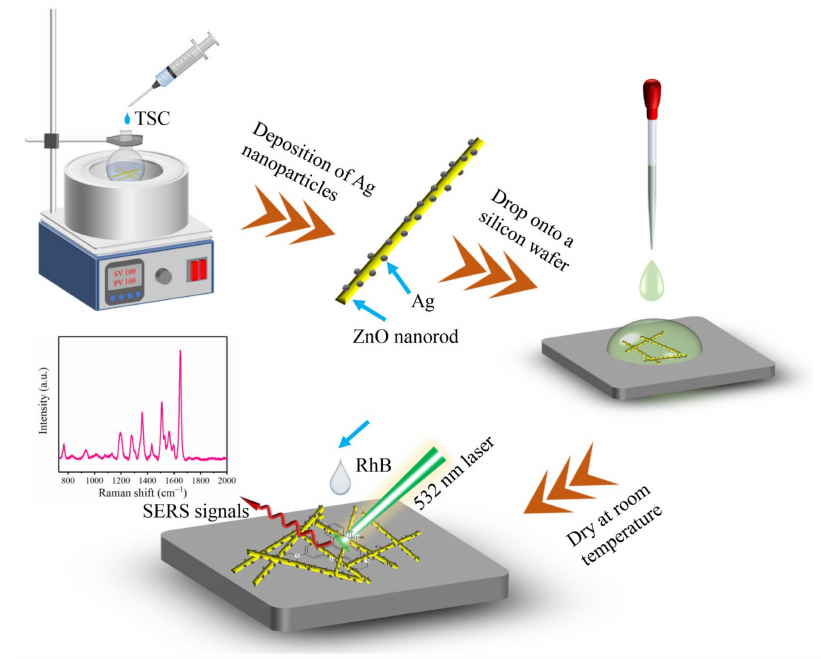
Figure 1. The preparation of the SERS substrate and SERS detection